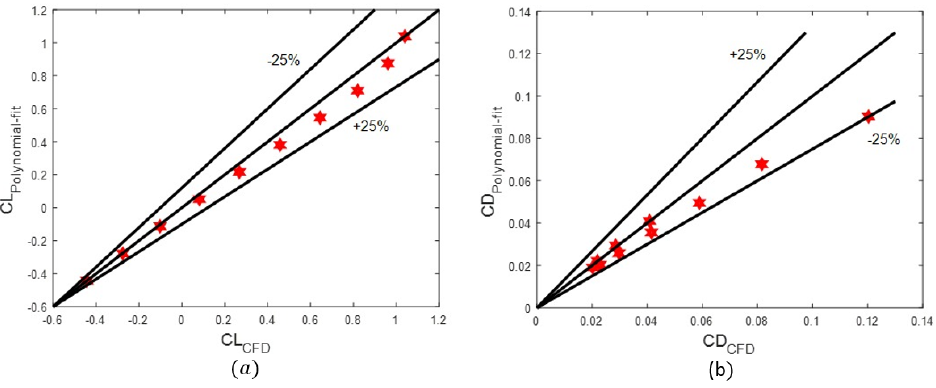
Figure 15. Percentage of errors between CFD and polynomial fit: ( a ) C L and ( b ) C D